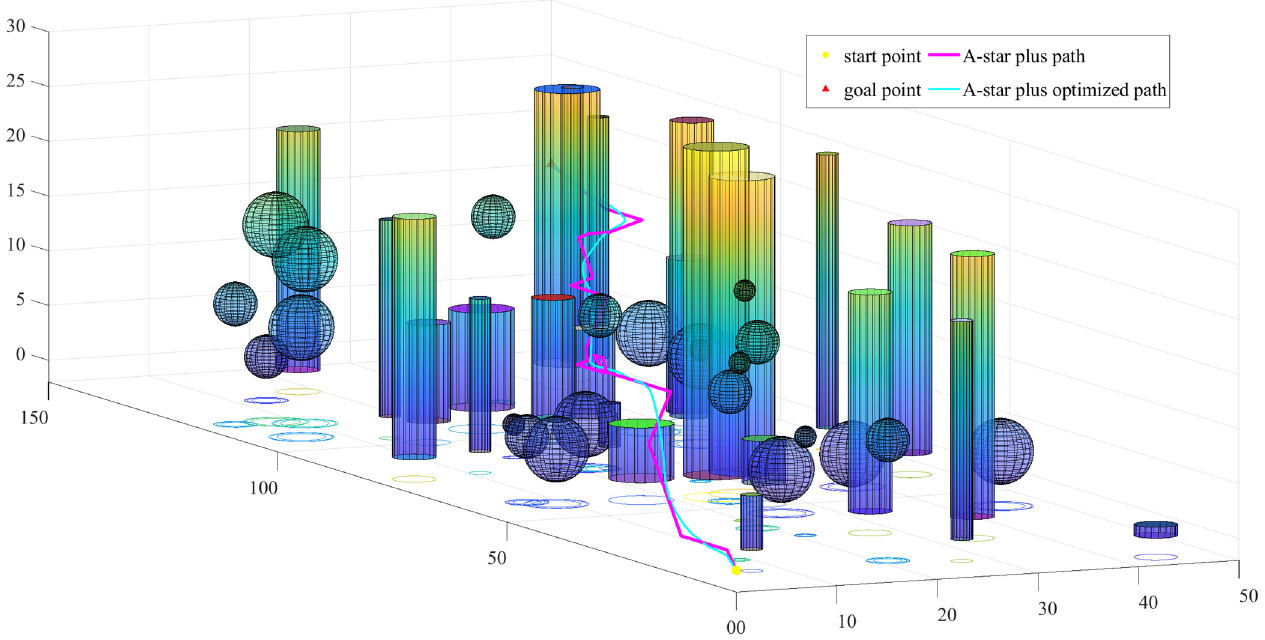
Figure 8. The fitting result of the improved algorithm on a 30 m × 90 m size map.